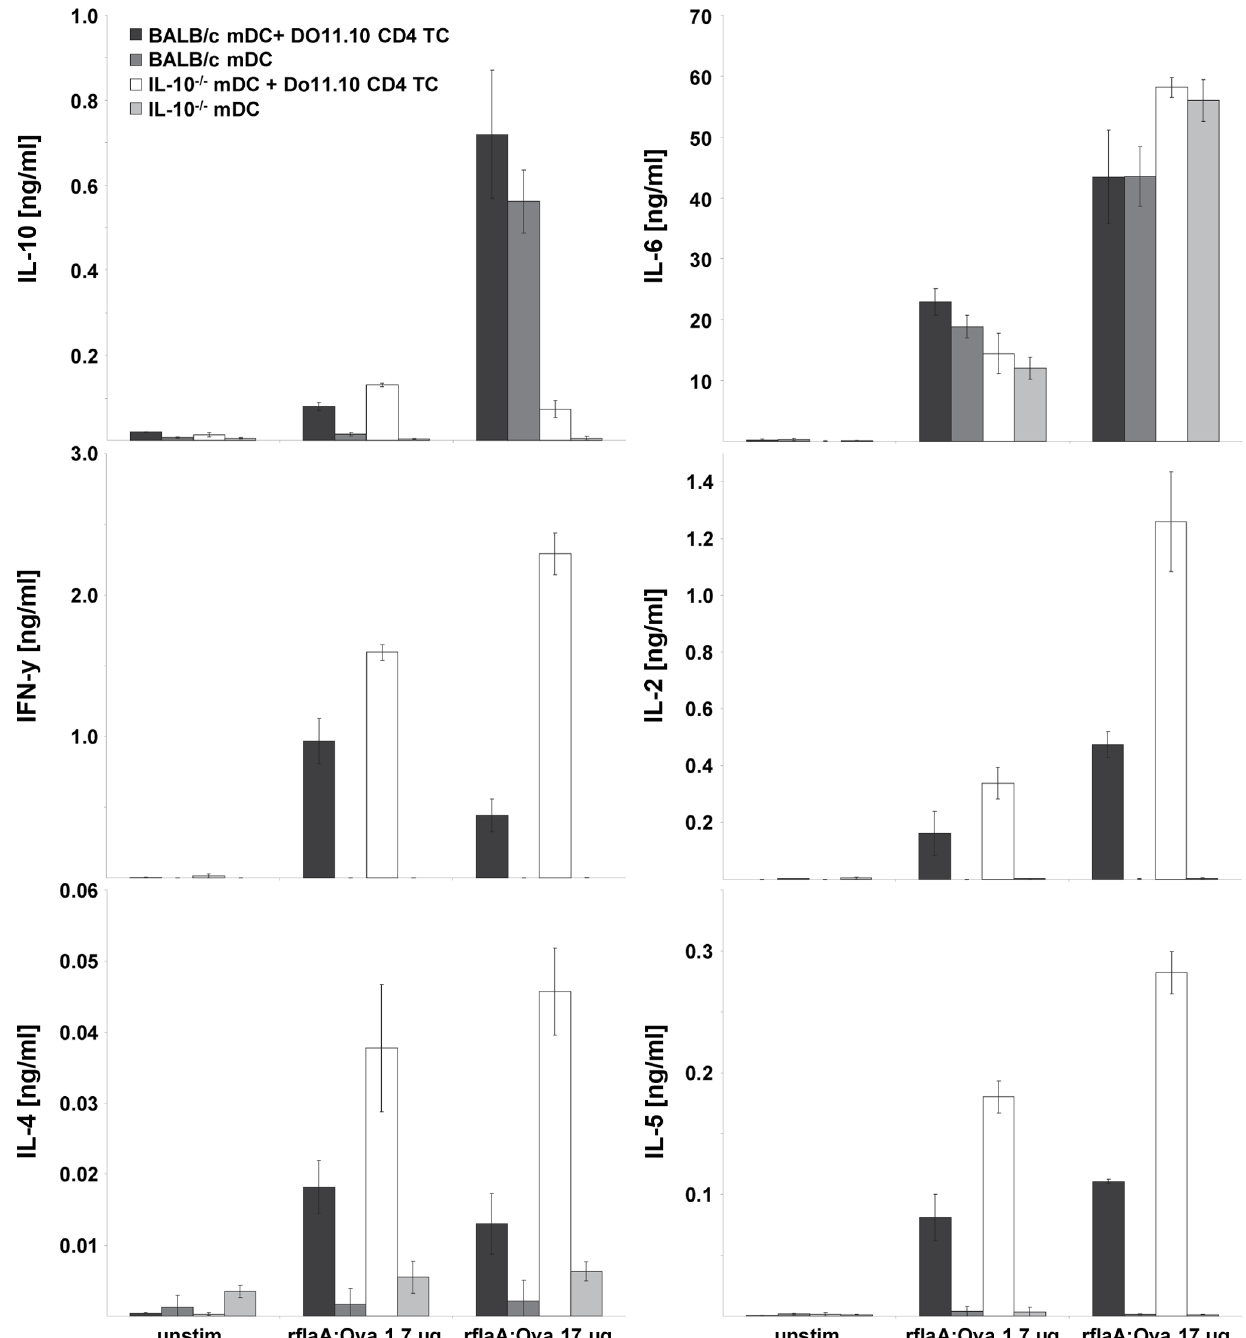
Figure 7. Suppression of TH1 and TH2 cytokine secretion by flaA:OVA is mediated by IL-10. BALB/c mDC derived from wt and IL-10 2 / 2 mice were co-cultured with DO11.10 CD4 + T cells and stimulated with rflaA:Ova, respectively. Levels of IL-2 in the culture supernatants were analyzed after 24 h, levels of IL-4, IL-5, IL-6, IL-10 and IFN-y were analyzed after 72 h. Results are means 6 SD of two independent experiments.